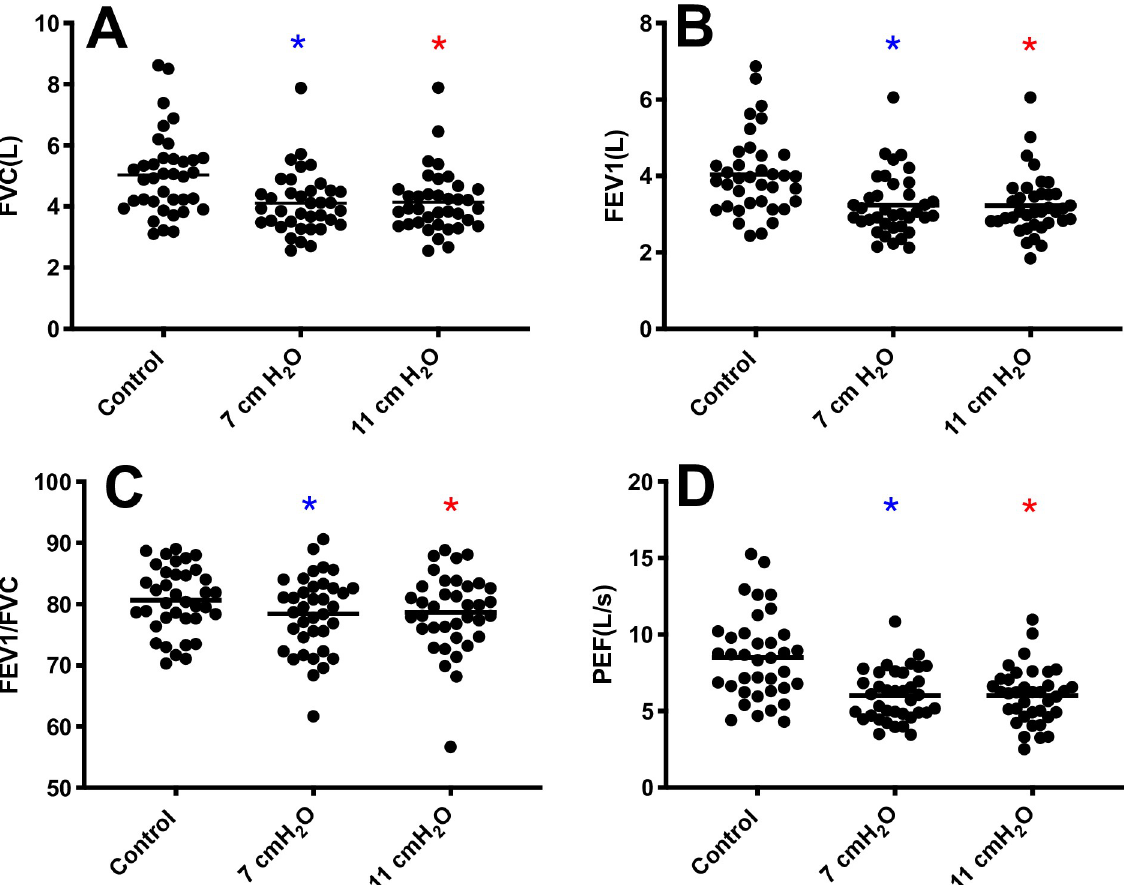
Fig 1. Spirometry variables with and without expiratory loading. Panel A: Forced vital capacity (FVC) was lower with 7 and 11 cmH 2 O of loading vs control (F[1.495, 55.31] = 77.71, p < 0.05). Panel B: Forced expired volume in 1 s (FEV1) was lower with 7 and 11 cmH 2 O of loading vs control (F[1.632, 60.38] = 67.54, p < 0.05). Panel C: FEV1/FVC was lower with 7 and 11 cmH 2 O of loading vs control (F[1.870, 69.17] = 5.553, p < 0.05). Panel D: Peak expiratory flow (PEF) was lower with 7 and 11 cmH 2 O of loading vs control (F[1.513, 55.99] = 72.69, p < 0.05). � Post hoc test showing different from control ( p <